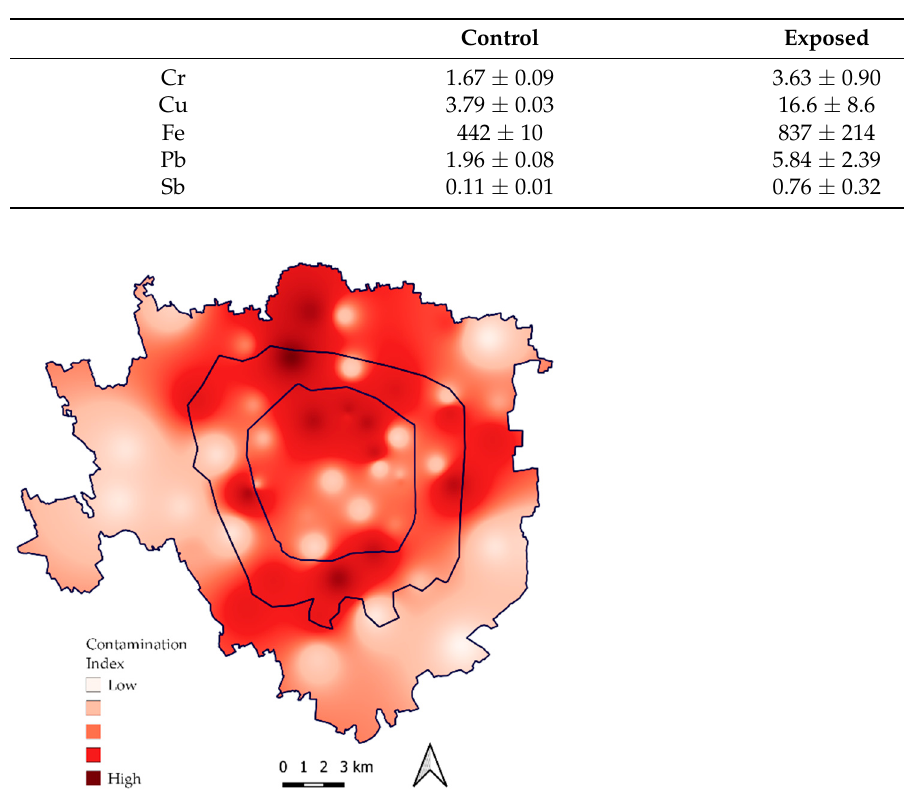
Table 1. Mean ( ± standard deviation) values ( µ g/g dw) of trace elements accumulated in control and exposed samples (from [28]).